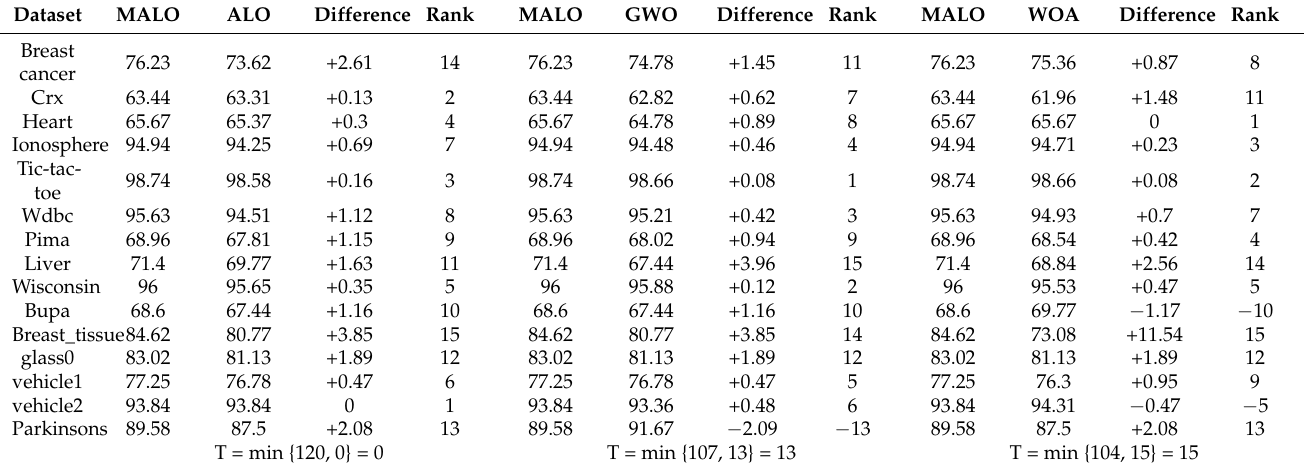
Table 12. Significance test of average bacc between MALO vs. ALO, MALO vs. GWO, and MALO vs. WOA.